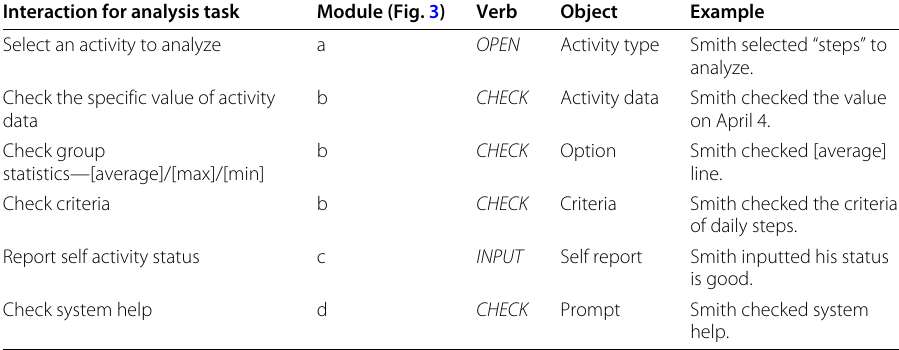
Table 1 Extraction of analysis behavior in the GOAL system Interaction for analysis task Module (Fig. 3) Verb Object Example